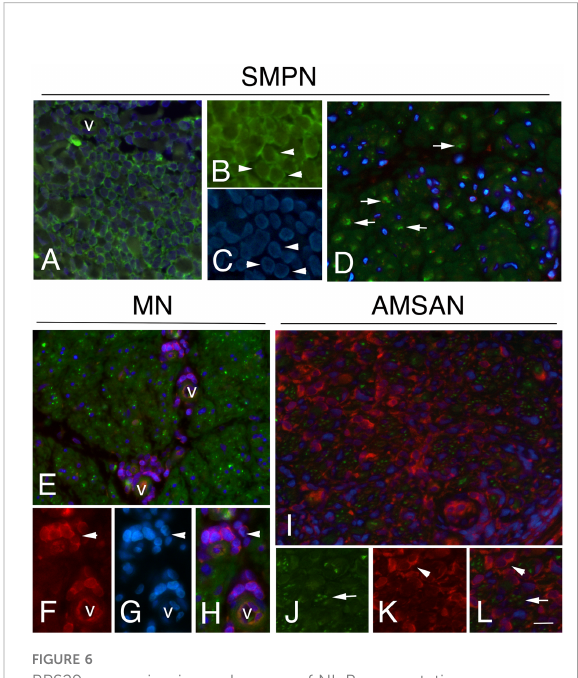
FIGURE 6 RPS29 expression in sural nerves of NL Representative micrographs of immunohistochemical staining with RPS29 marker in. NL. In all cases, RPS29 was express by malignant B- cells. (A-C) positive malignant B-cells in epineurium in SMPN (arrowheads, in A v marks a vessel); axons (green) ( D , arrows) showing the absence of RPS29 (red) staining. (E-H) : RPS29 (red) perivascular positive malignant B-cells in endoneurium in MN ( F- H , arrowhead, v marks endoneurial vessels) with negative axons (green). (I-L) diffuse RPS29 immunoreactivity in patients with AMSAN (I) : positive B-cells in endoneurium ( K, l , arrowheads), axons were negative for RPS29 ( J - L , arrows). Scale bar represent 20 m m (A, D, E, I) ; 10 m m (B, C, F-H, J-L)